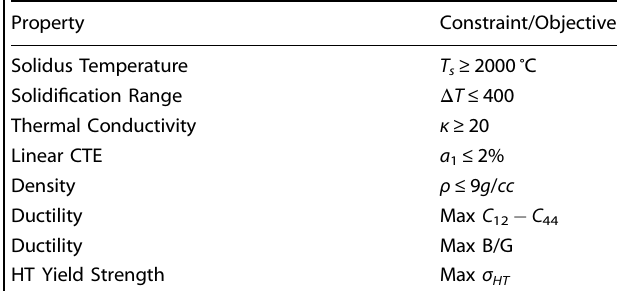
Table 1. The fi ve constraints and the three objectives associated with the design problem addressed in this